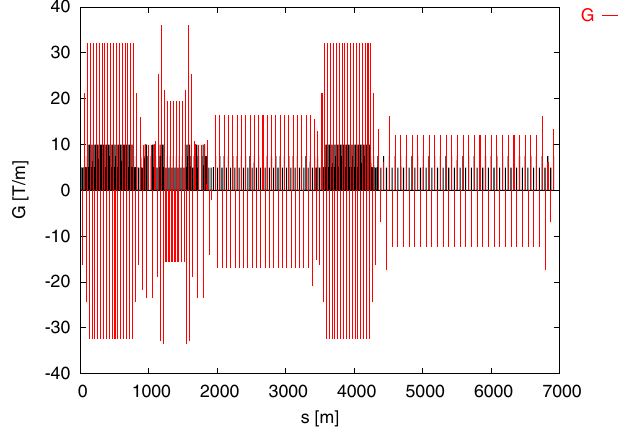
FIG. 38. Gradients of the quadrupoles in the beta-beam decay ring.